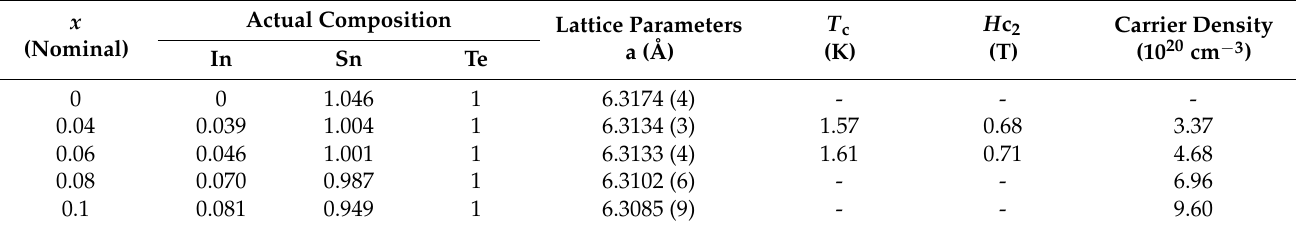
Table 1. Actual composition, lattice parameter, T c , H c 2 and carrier density of In x Sn 1 − x Te crystals, note that the actual composition was normalized to Te content.